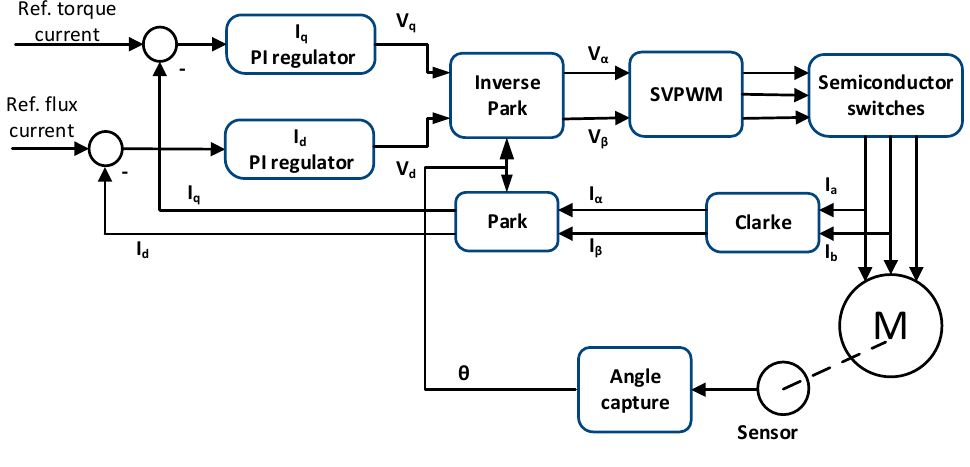
Figure 8. The FOC of IM in pumping application.